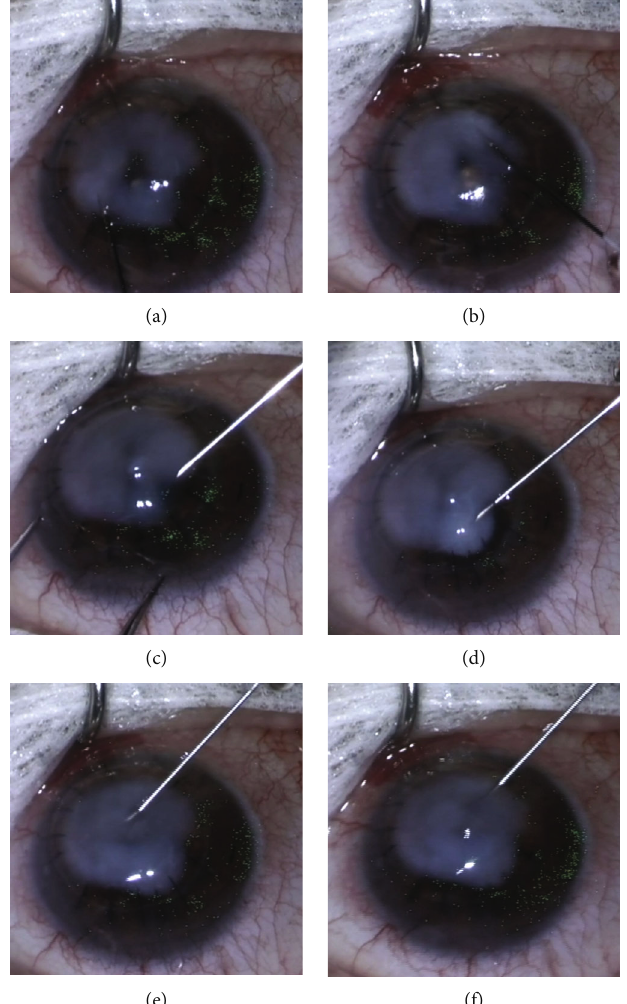
Figure 3: Image series from surgical video demonstrating the intrastromal antibiotic injections through a 30-gauge needle. The injections were made in a circular pattern surrounding the crystalline deposits, achieving a higher concentration centrally and keeping the needle tracks away from the visual axis (image progression from (a) to (f)). Full video available here in https://www.dropbox.com/s/